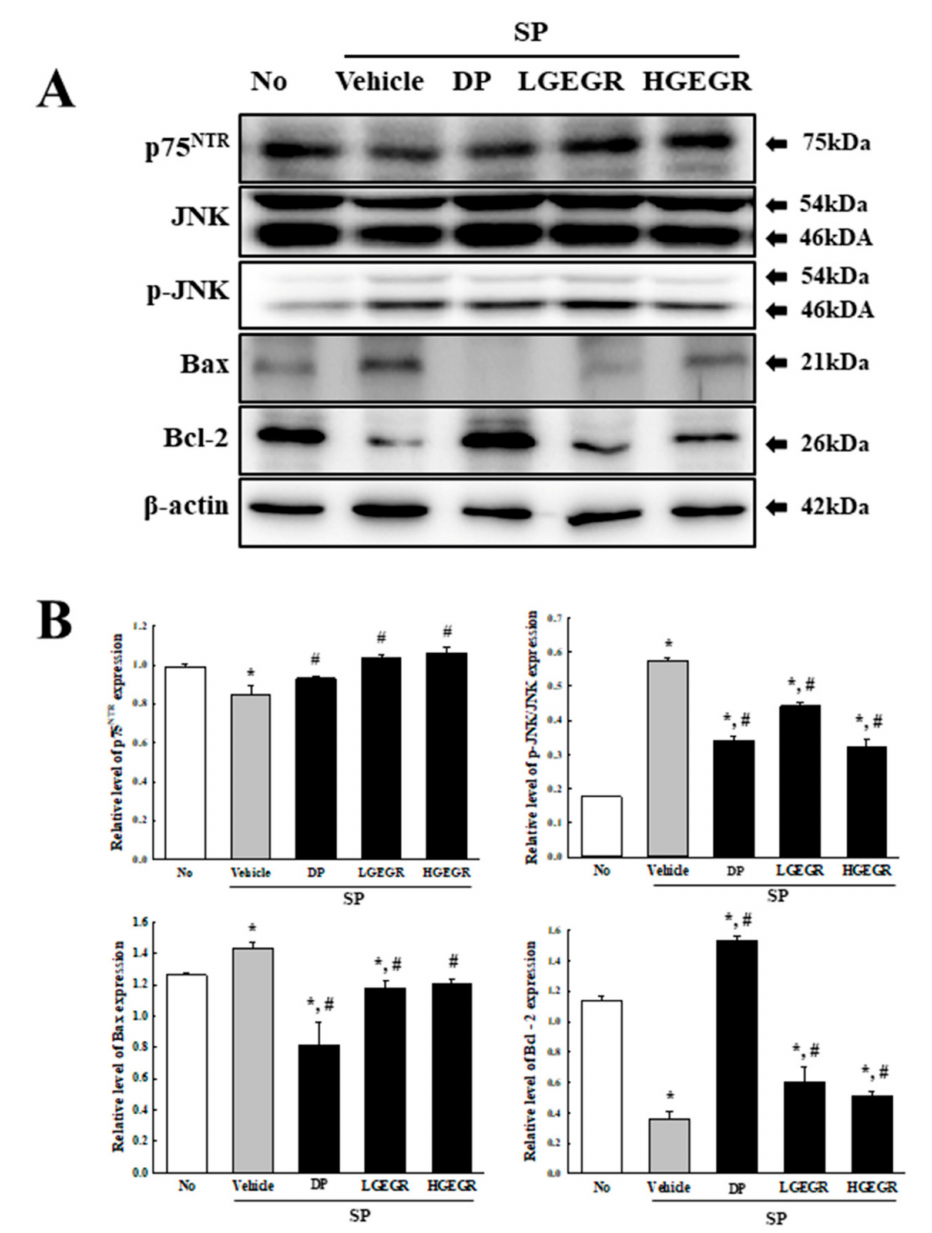
Figure 6. Alteration of the p75 neurotrophin receptor (p75 NTR ) receptor signaling pathway. Total tissue homogenates were prepared from brains of Vehicle or GEGR treated SP-injected mice as described in Materials and Methods. Total protein (50 µ g per sample) was immunoblotted with p75 NTR , JNK, p-JNK, Bax, Bcl-2, or β -actin antibodies. After determining individual band intensities using an imaging densitometer, the relative levels of the proteins were based on the intensity of actin. Three samples were assayed in duplicate by western blotting. Data are reported as mean ± SD values. * p < 0.05 compared with the No treated group. # p < 0.05 compared with the SP + Vehicle treated group. Abbreviation: DP, donepezil; GEGR, gallotannin-enriched extract of Galla Rhois; SP,